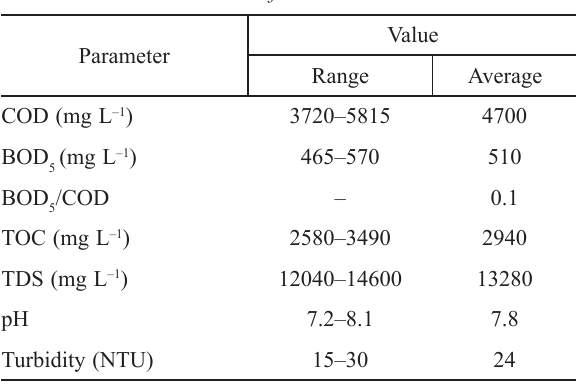
Table 4 – Characteristics of raw wastewater